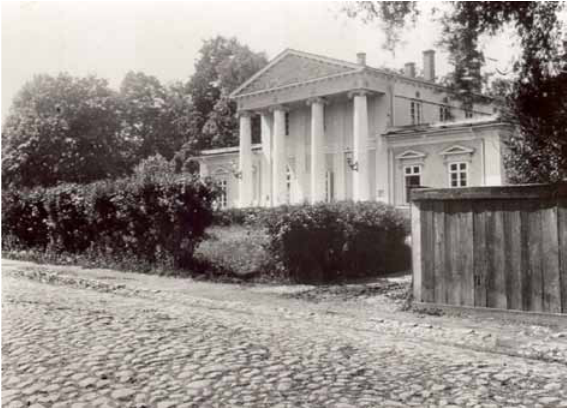
fig. 9. Villa Medem, the 90s of the 19 th century Source: a photo of History Museum of jelgava